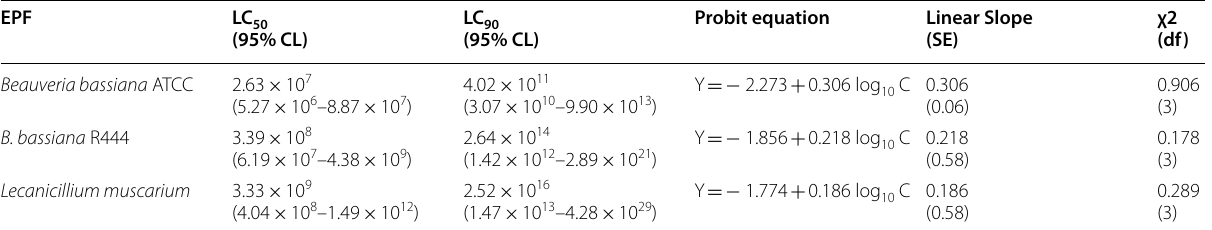
Table 3 Probit analysis at 7 days after treatment with Beauveria bassiana ATCC, B. bassiana R444 and Lecanicillium muscarium against 2nd instar Tuta absoluta larvae by the first method